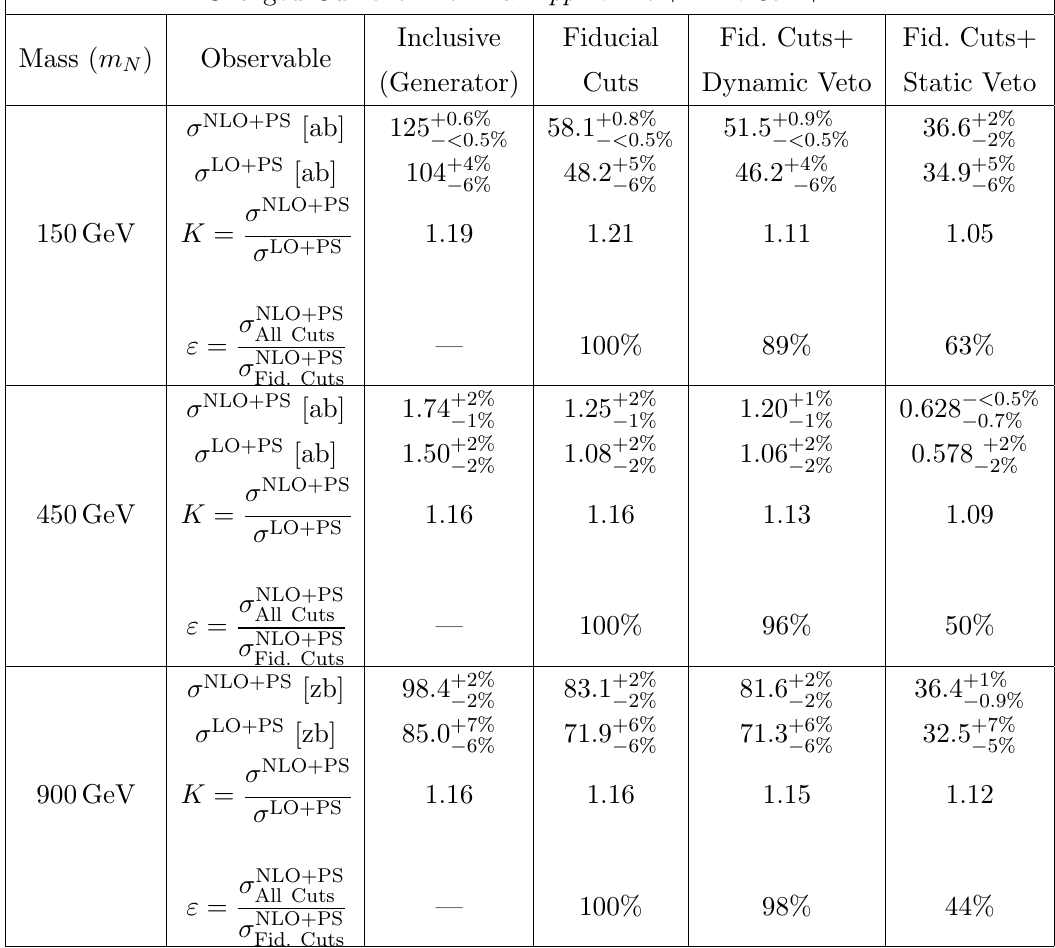
Table 2. For the CC DY pp N‘ + X 3 ‘(cid:23) + X signal process, with e (cid:22)= no- (cid:28) mixing as given ! ! (cid:0) in eq. (3.18) and representative m N , the total inclusive cross section and QCD scale uncertainty [%] at p s = 14 TeV, the cross section after the nominal kinematical and (cid:12)ducial cuts of eq.